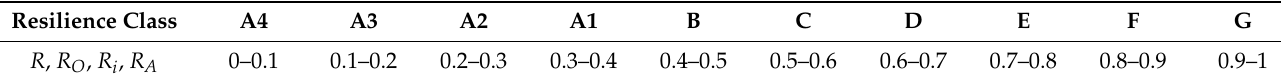
Table 7. 10 level resilience scale from 0 to 1 proposed to attribute a resilience class as a function of the values resulting from the resilience metrics R , R O , and R A .